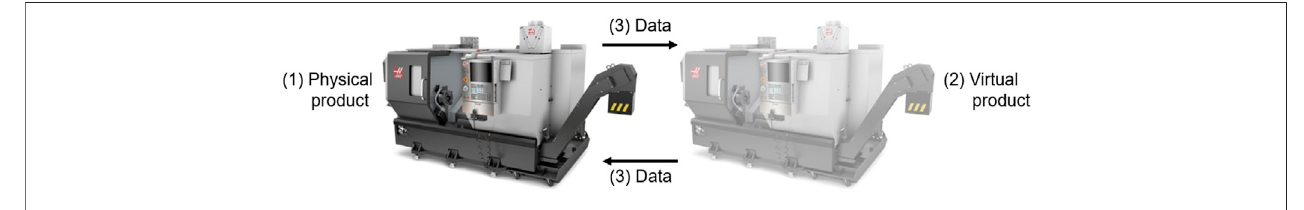
FIGURE 1 | The Digital Twin concept, from Grieves (Grieves,